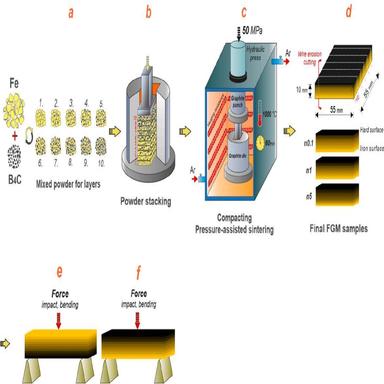
Schematic representation of the fabrication process of FGM samples, a− d, and mechanical test procedure, e− f.